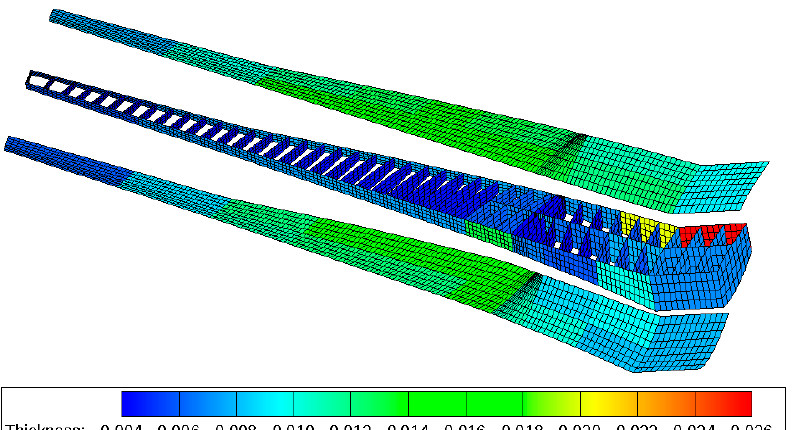
Figure 20. Sizing load cases for each design field—reference.